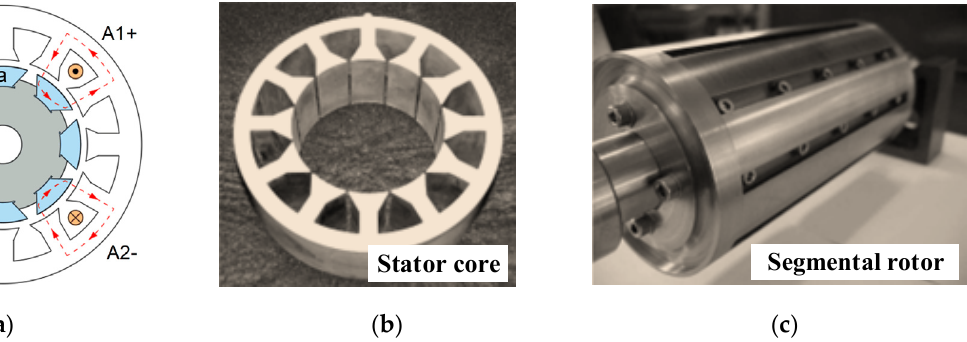
Figure 2. Proposed 12/8 segmental rotor SRM with FPW. ( a ) is the topology of proposed SSRM where “a” is the segmental rotor and “b” is the rotor block; ( b ) and ( c ) is the stator and rotor core.